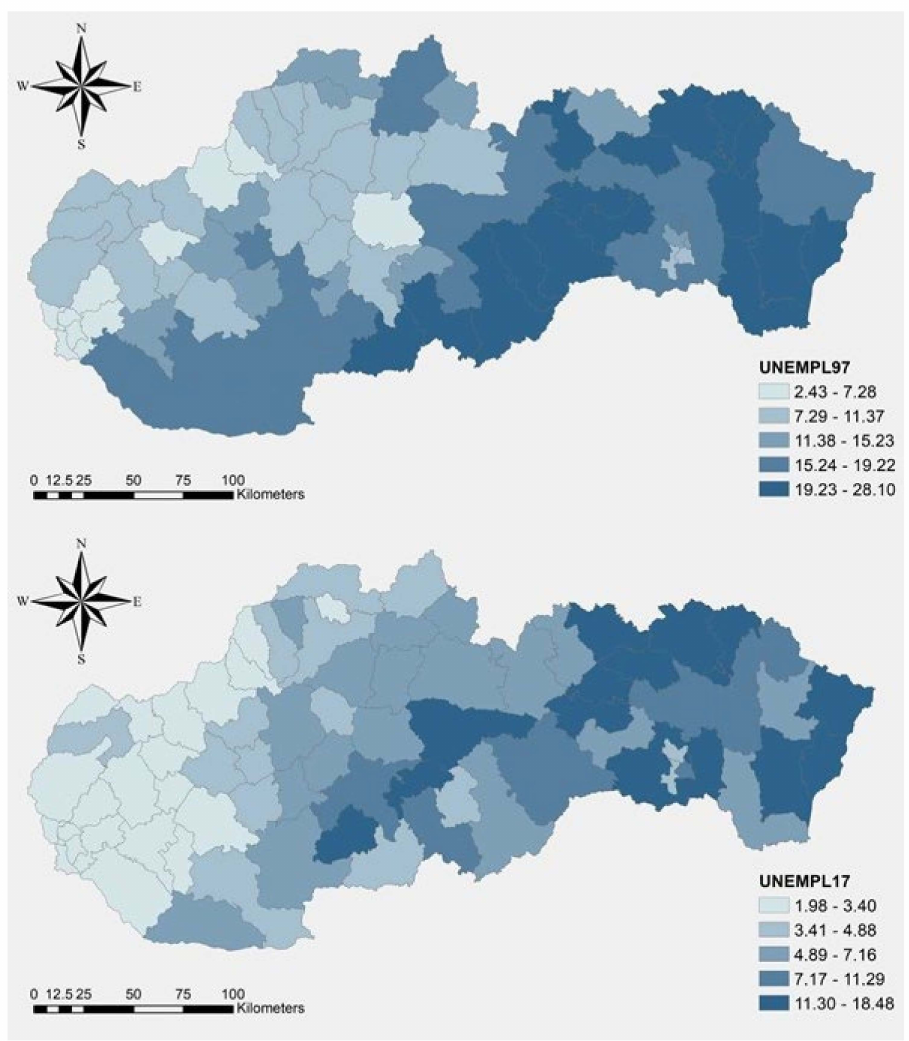
Figure 3. The unemployment rate in Slovak districts 1997 and 2017 (%). Source: SOSR